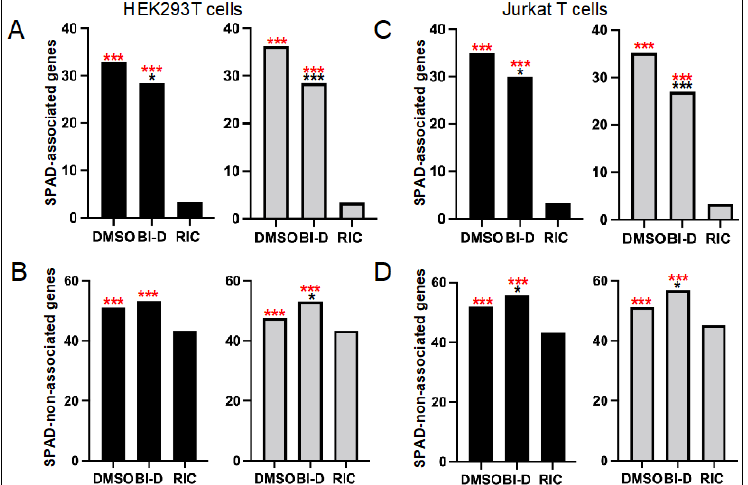
Figure 4. HIV-Luc produced in the presence of BI-D is defective for integration into SPAD-associated genes. ( A ) Percent integration in SPAD-associated genes in HEK293T cells is shown for two independent infections, with replicate 1 data plotted to the left. ( B ) Percent integration in SPAD-non-associated genes for the infections shown in panel ( A ). ( C ) Same as in panel ( A ) except that infections were conducted with Jurkat T cells. ( D ) Percent integration in SPAD-non-associated genes for the infections shown in panel ( C ). Asterisks show differences versus matched RIC (red) and DMSO (black) controls. *, p < 0.05; ***, p < 0.0001—see Table S3 for detailed statistical analyses.